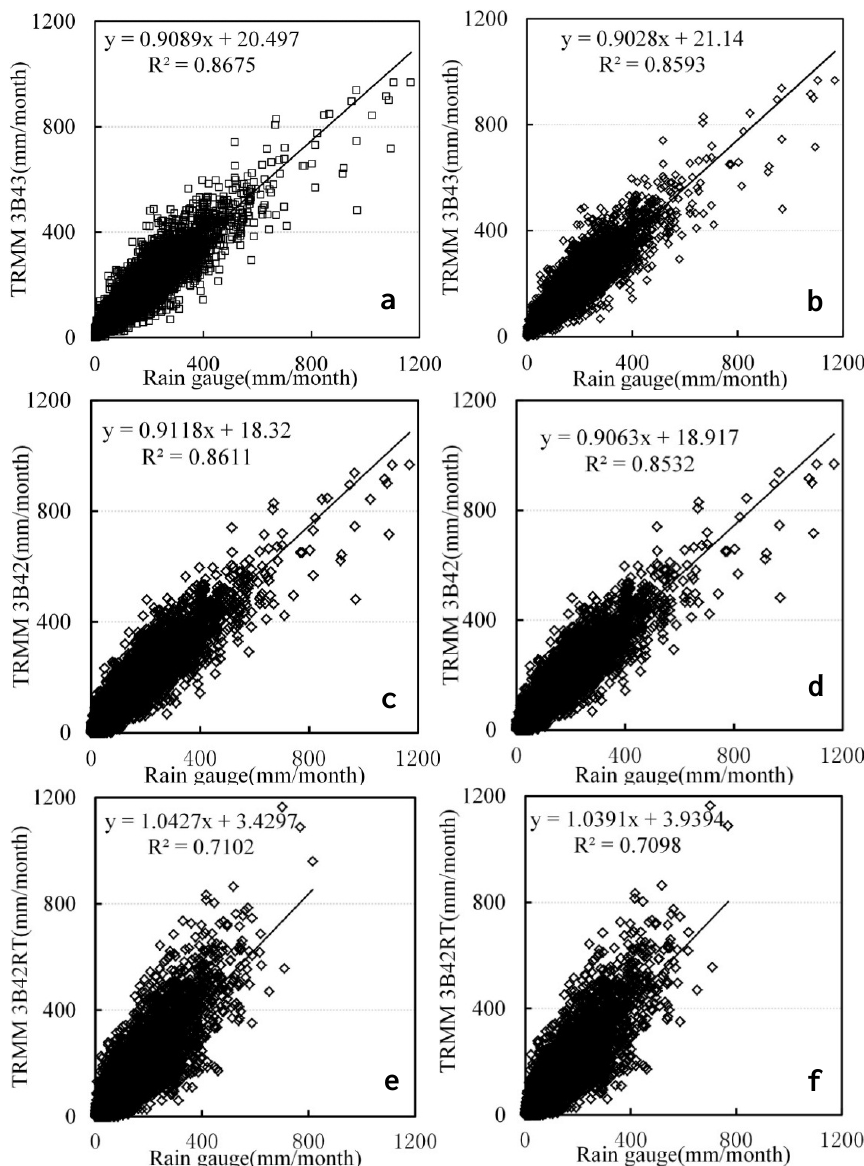
Figure 2. Scatter plots of monthly satellite products (Tropical Rainfall Measuring Mission (TRMM) 3B43, 3B42 and 3B42RT) versus monthly rain ‐ gauge data at 0.25° × 0.25° pixel scale for the period from 1998 to 2007 (3B42RT: 2000–2007), with ( a , b ) for TRMM 3B43; ( c , d ) for TRMM 3B42; ( e , f ) for TRMM 3B42RT; ( a , c , e ) for reference data with Global Precipitation Climatology Centre (GPCC) reporting gauges; ( b , d , f ) reference data without GPCC reporting gauges.